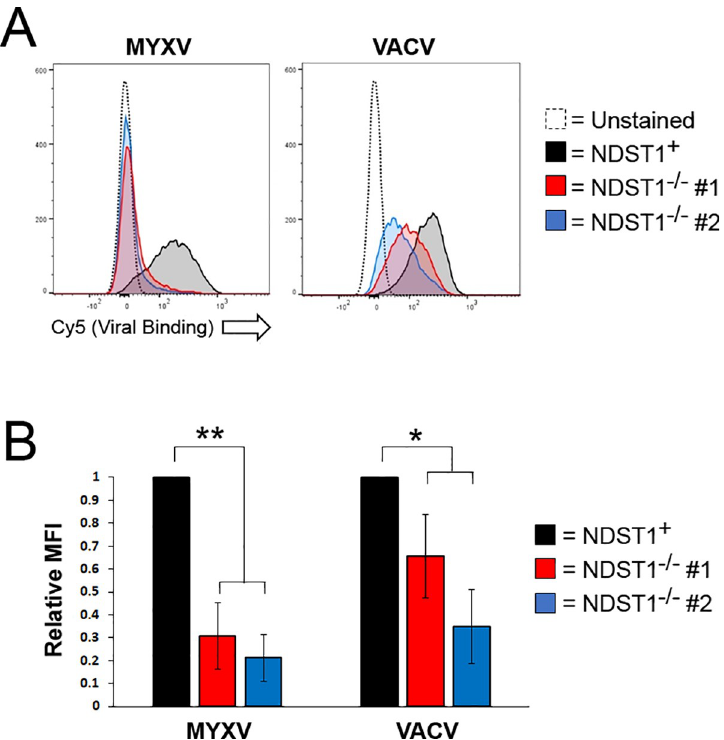
Fig 2. Loss of sulfation reduces binding of both MYXV and VACV virions. (A) Histograms depicting binding of fluorescent viral virions to the cell surface. Cells were incubated on ice with Cy-5 labeled MYXV or VACV at 4 particles per cell and washed with cold PBS to remove residual virus. Cells were resuspended in 2% PFA and levels of Cy-5-labeled virus bound to the cell membrane was measured via flow cytometry. Data shown is representative of two independent experiments each done in triplicate. (B) Relative MFI values of Cy-5 (viral binding). MFI values were normalized to NDST + to determine the relative change in NDST -/- cell lines. Statistical MFI calculations are a summation of the two independent experiments each conducted in triplicate. Statistical significance was determined using non-parametric Mann-Whitney test. �� = p < 0.01, � = p <